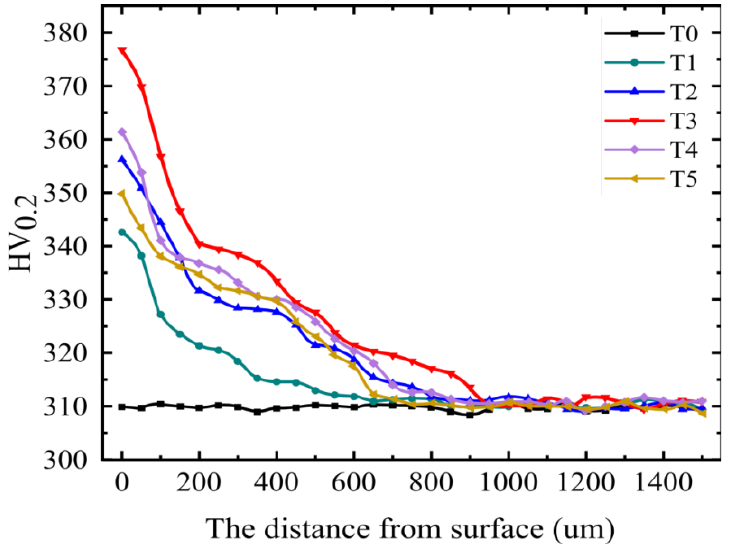
Figure 11. Microhardness profiles in cross-sections of samples.